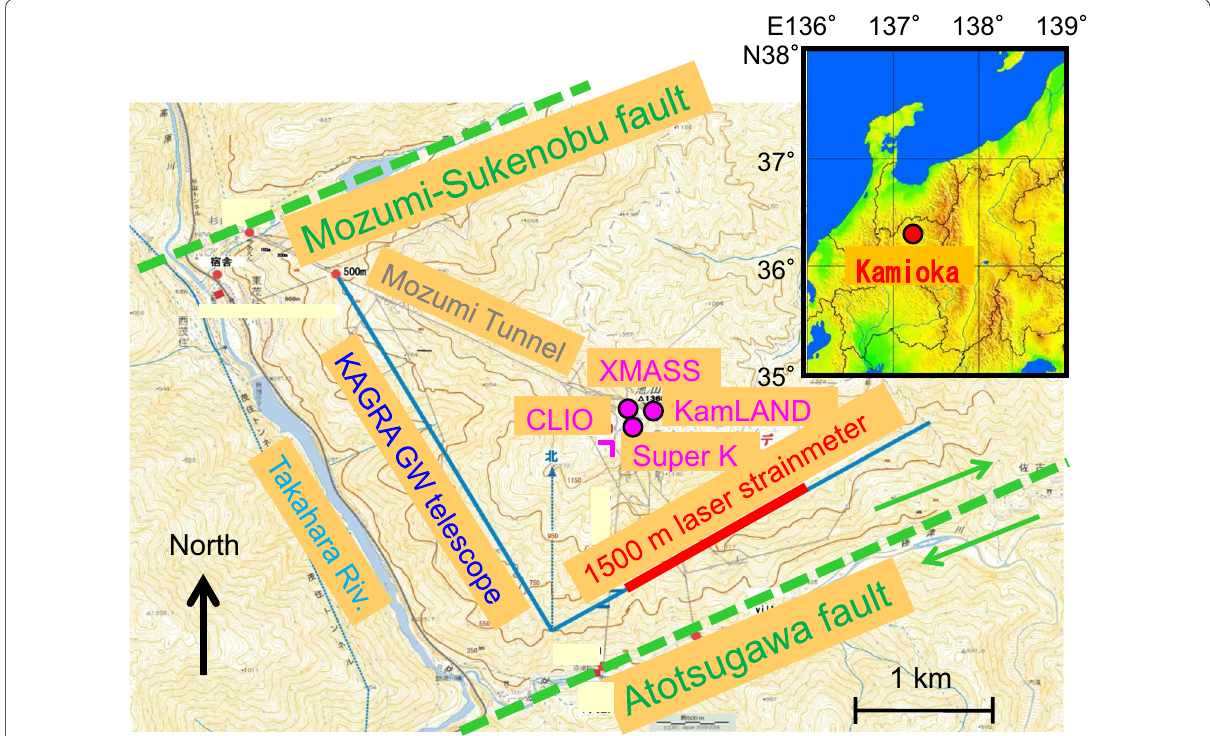
Fig. 1 Location of the 1500-m laser strainmeter and other facilities at the Kamioka underground site. The Atotsugawa fault is located approximately 0.5 km from the strainmeter and is almost parallel. This figure is modified from a map released by the Geospatial Information Authority of Japan